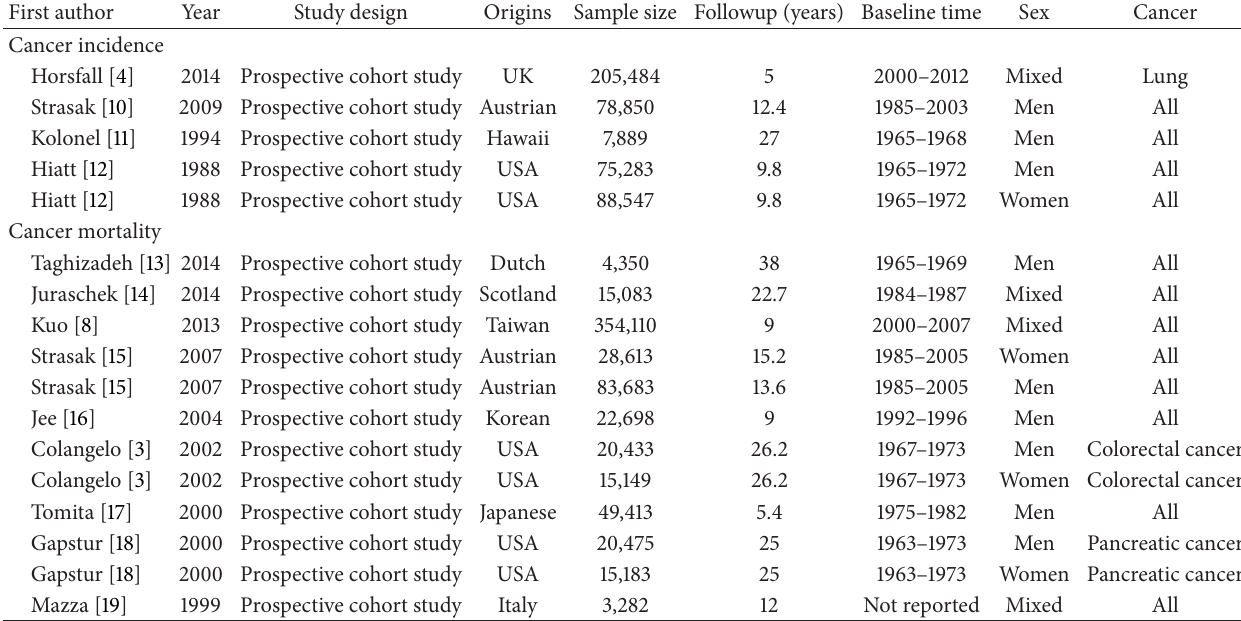
Table 1: Characteristics of all